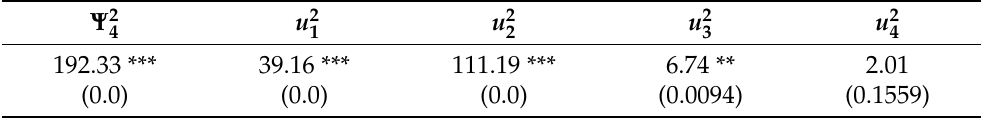
Table 6. Smooth statistics and p -values (whole